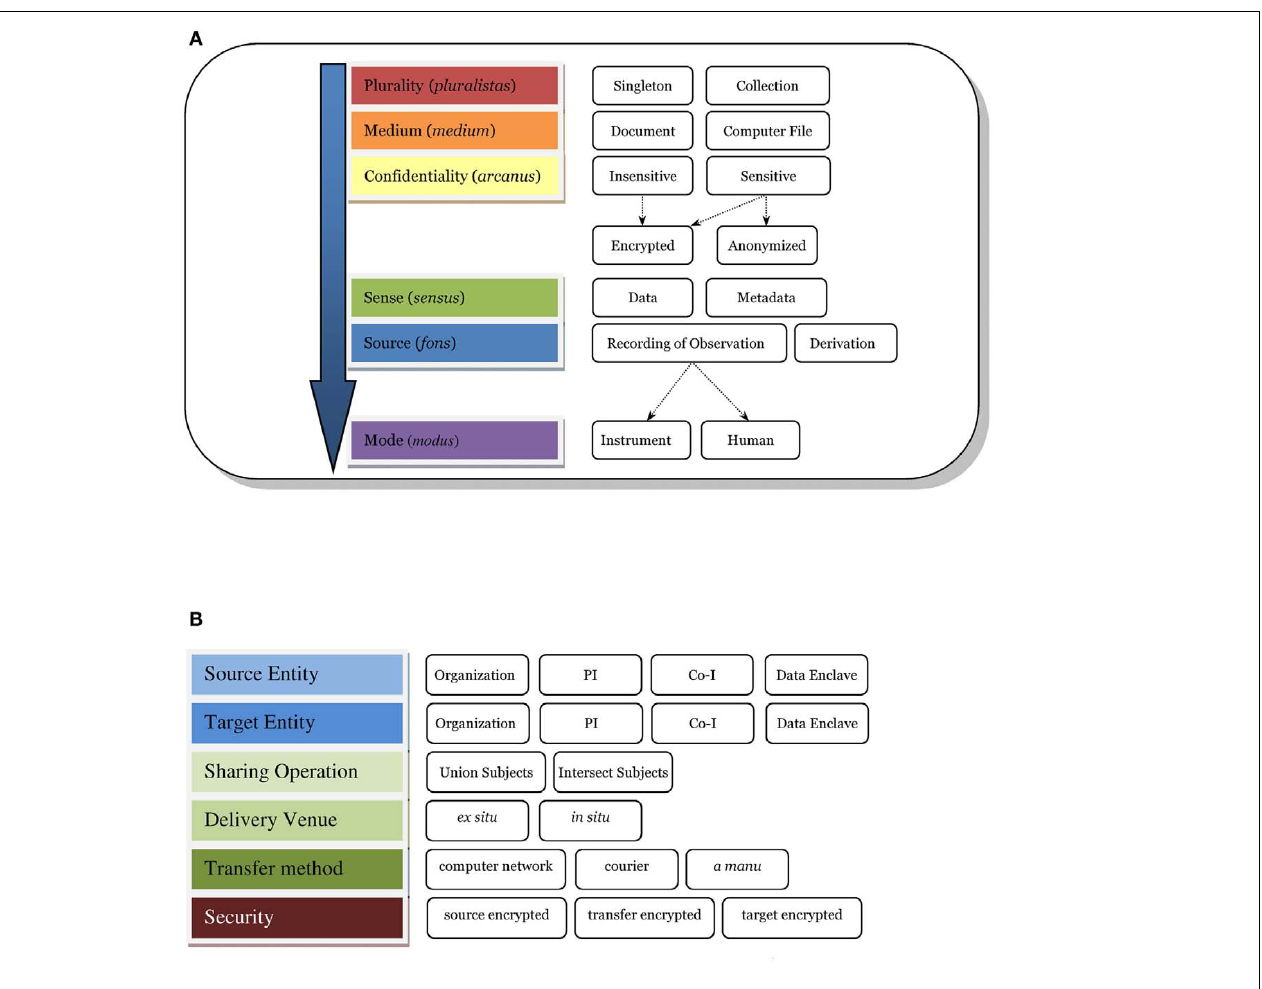
FIGURE 1 | Data sharing taxonomy. (A) e.g., A DICOM file may fit within the taxonomy as follows: plurality = singleton; medium = computer file; confidentiality = sensitive, anonymized; sense = data and metadata; source = recording of observation; mode = instrument. if the dicom file were encrypted then confidentiality = sensitive,